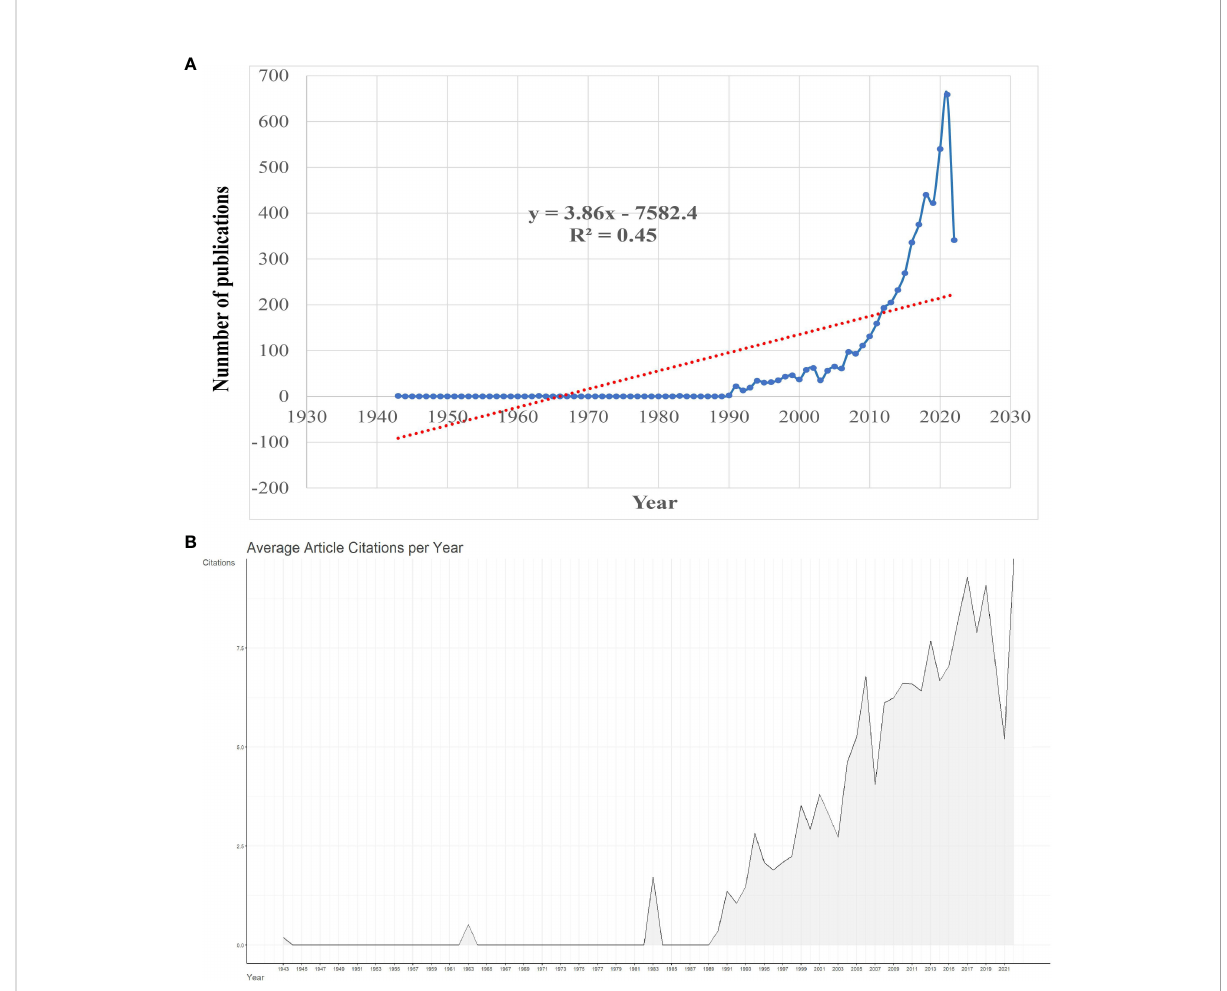
FIGURE 2 Overview of publications on pancreatic cancer metabolism. (A) Global annual output trends; (B) Global annual citations